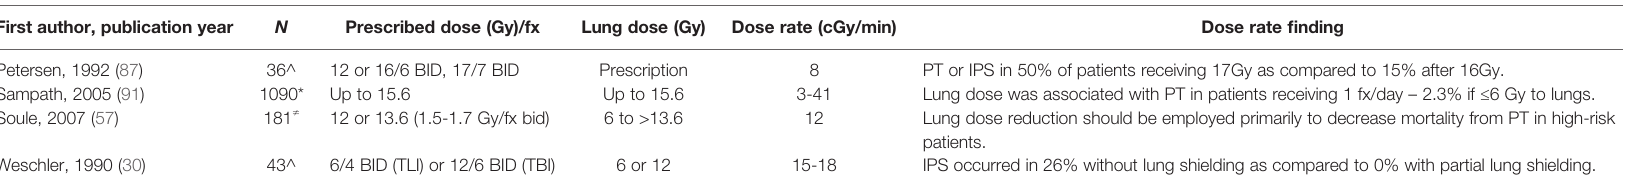
TABLE 7 | Summary of key literature reports on the effect of lung